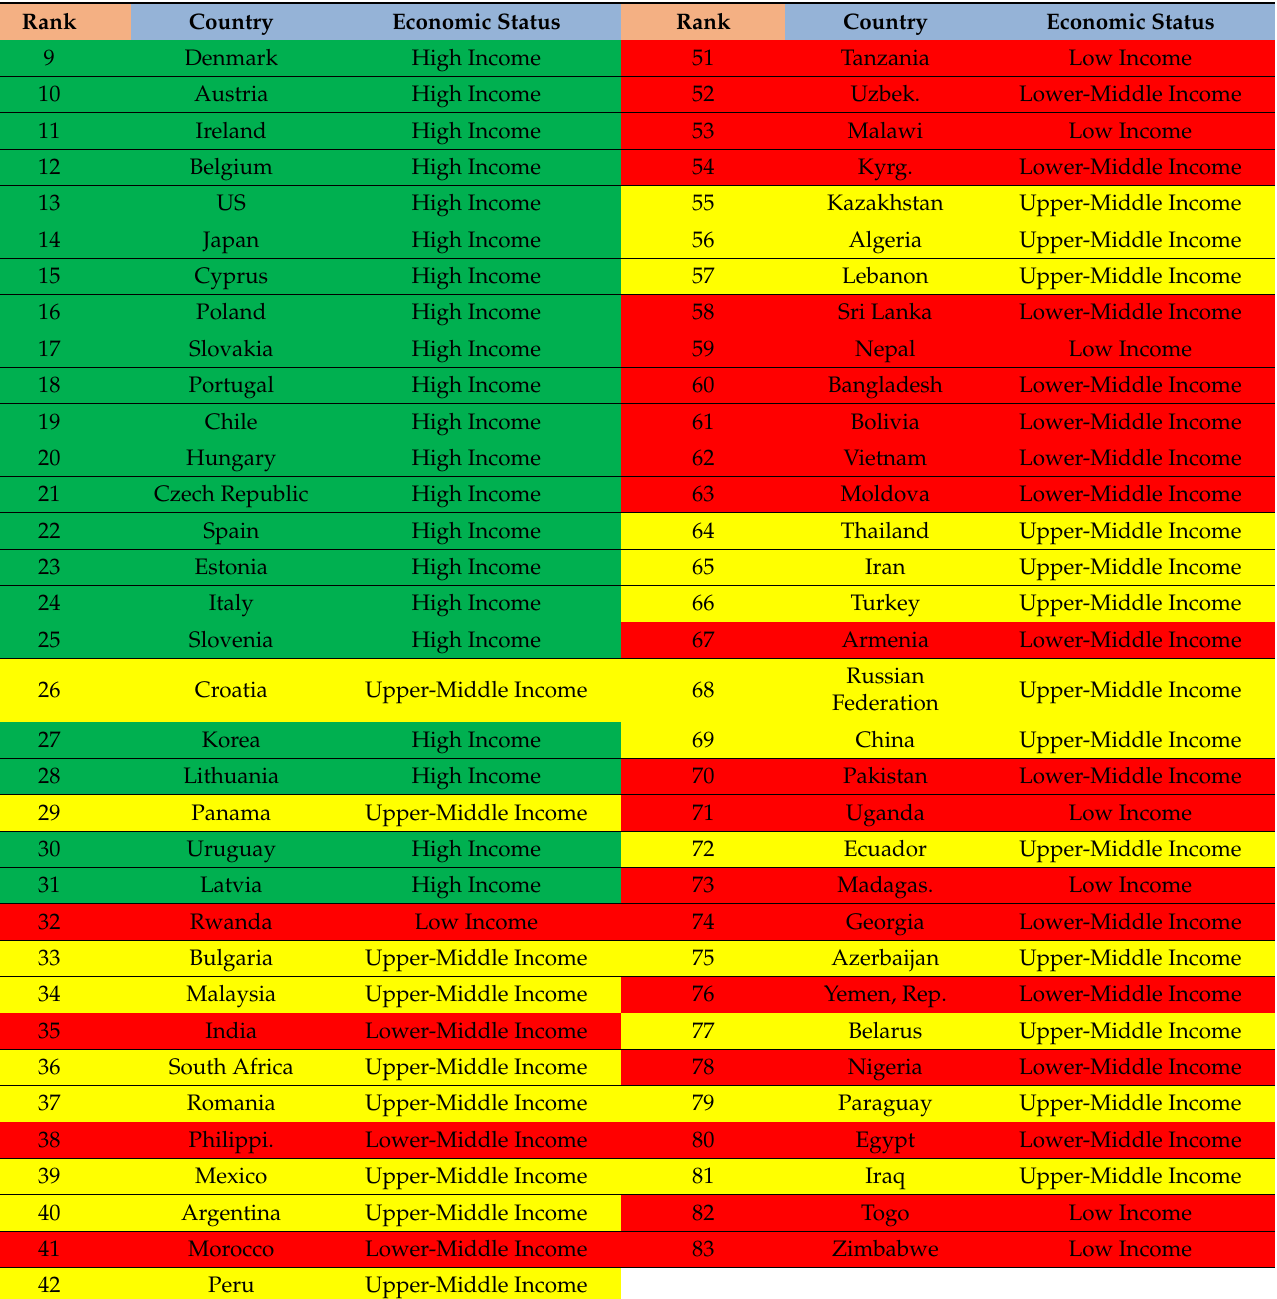
Peru Upper-Middle Income Note: green color is for high income (HYC), yellow shows middle income (MYC), and red shows low in- come